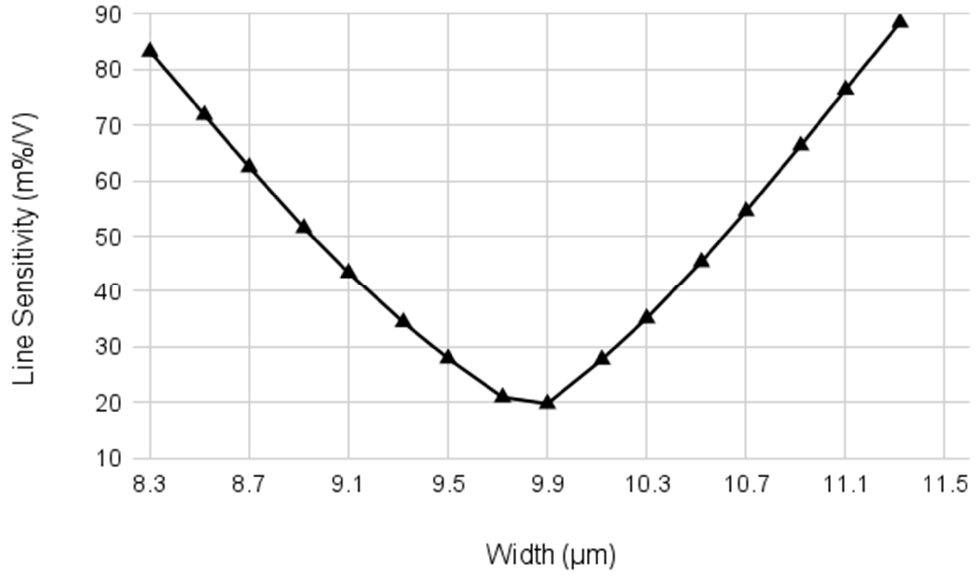
Figure 5. Line sensitivity depending on the width of M4.